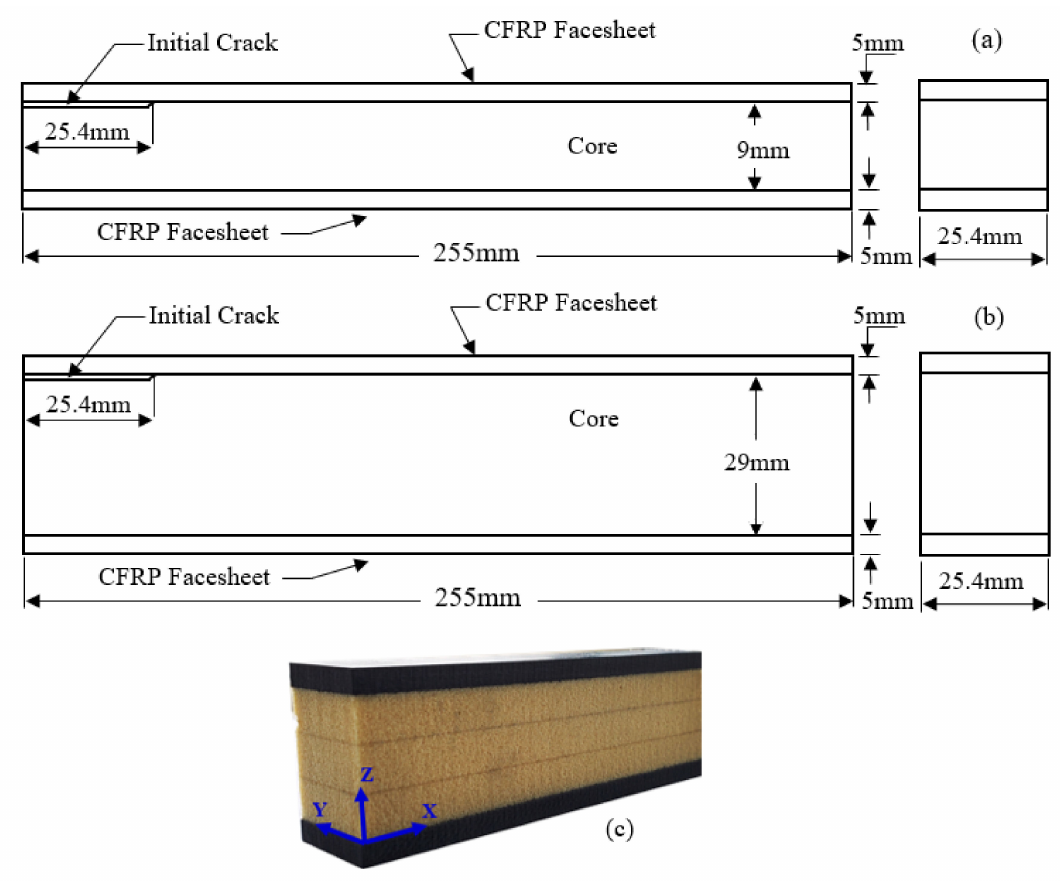
Figure 1. ( a , b ): Geometrical dimensions of di ff erent specimens studied; ( c ) Isotropic view of sandwich beam developed with thick Polyurethane (PU) foam